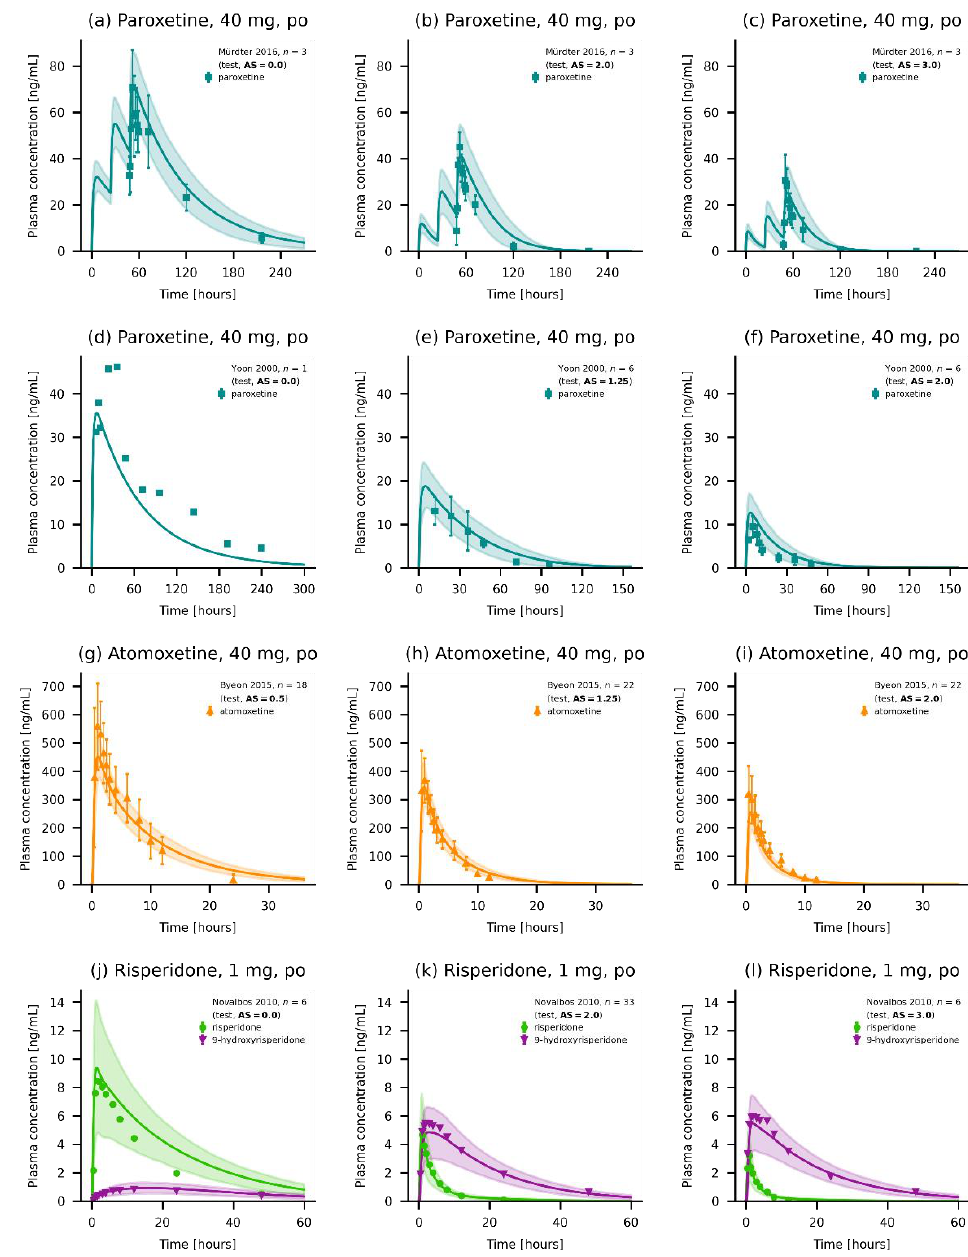
Figure 5. Simulated plasma concentrations of the modeled compounds for different CYP2D6 activity scores. ( a – f ) Paroxetine [33,40], ( g – i ) atomoxetine [41] and ( j – l ) risperidone [54] plasma concentration– time profiles of selected CYP2D6 DGI studies, compared to their observed data [33,40,41,54]. Individual predictions are shown as lines. Population predictions ( n = 1000) are shown as lines with ribbons (arithmetic mean ± standard deviation (SD)), and symbols represent the corresponding observed data ± SD (if available).